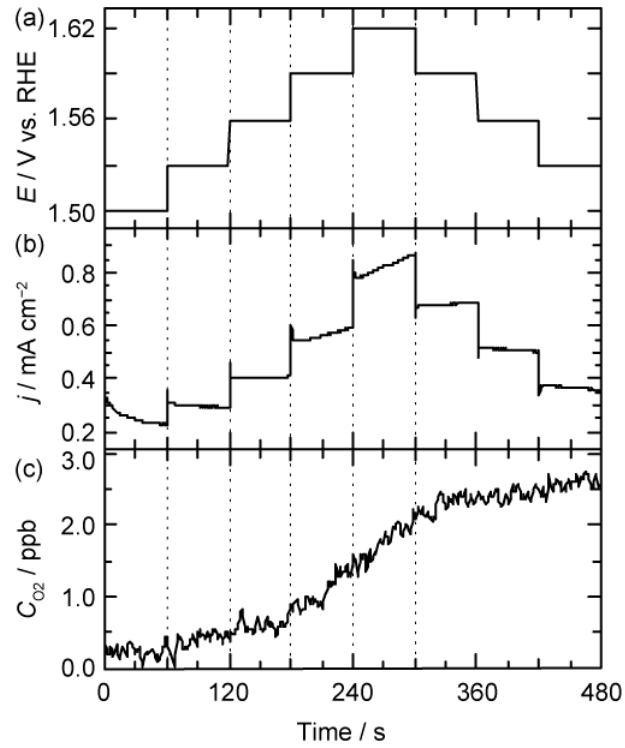
Figure 1. OER from F–carbon in 0.1 M KOH solution (pH = 13). ( a ) Applied potential ( E ), ( b ) current density ( 𝑗 (cid:2930)(cid:2925)(cid:2930)(cid:2911)(cid:2922) ), and ( c ) O 2 concentration ( 𝐶 (cid:2899) ) were plotted versus time.